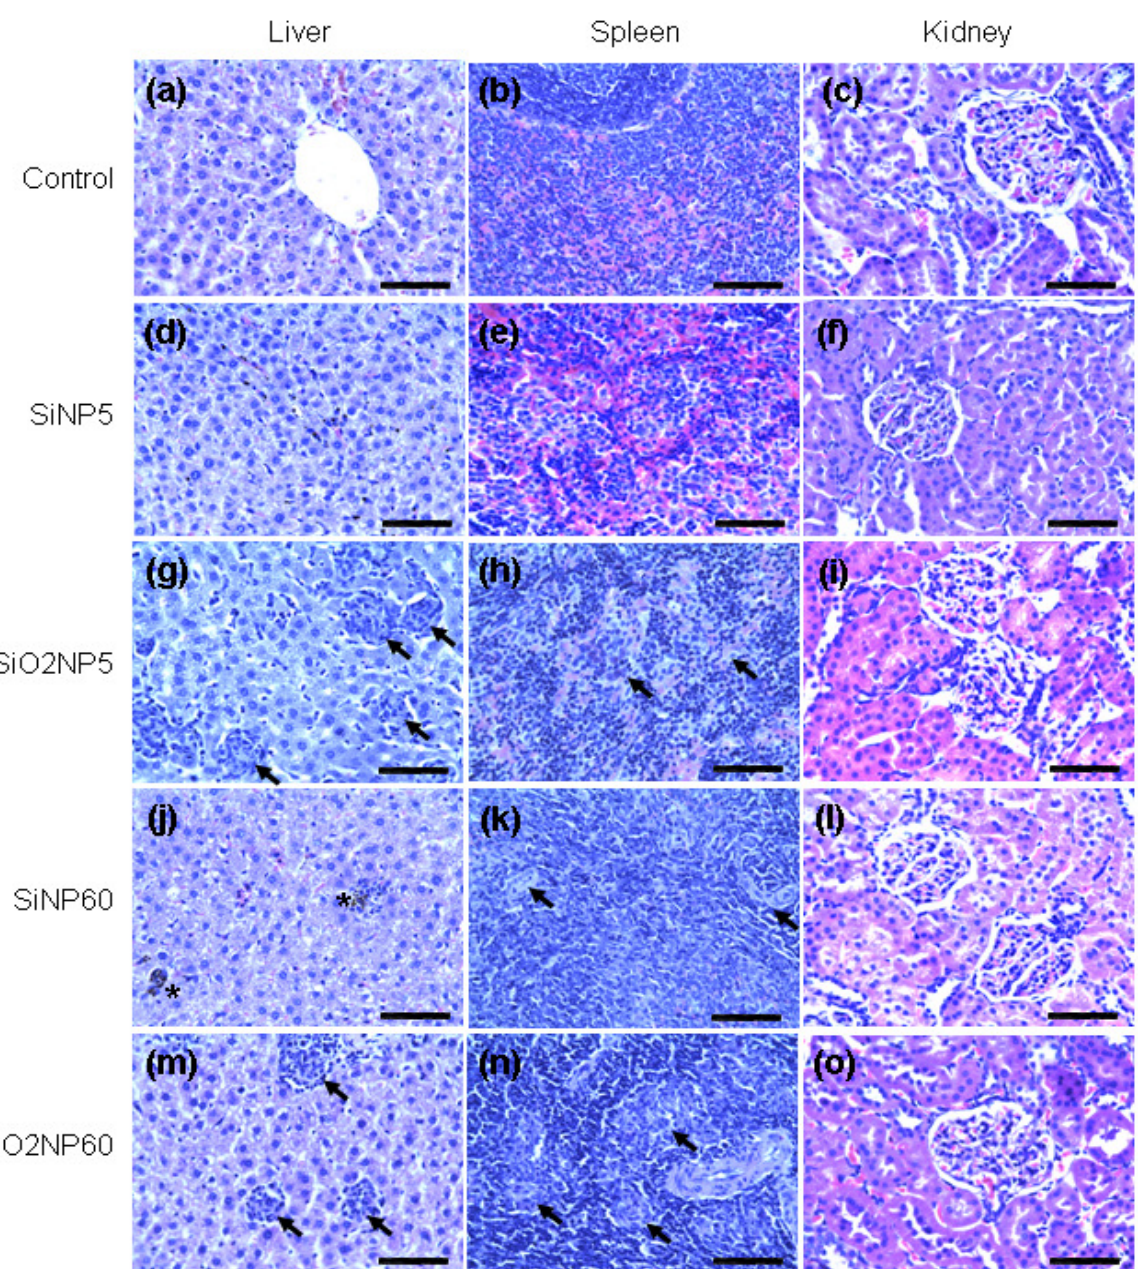
Figure 6. Histological evaluation of organs from rats treated with SiNPs or SiO NPs. Liver, 2 spleen, and kidney samples were collected at 5 and 60 days after intravenous administration of SiNPs or SiO NPs at a dose of 7 mg/kg and fixed with paraformaldehyde, 2 followed by staining with hematoxylin & eosin. ( a–c ) Vehicle-treated animals (controls); ( d–f ) 5 days after SiNP treatment (SiNP5); ( g–i ) 5 days after SiO NP treatment (SiO NP5); 2 2 ( j–l ) 60 days after SiNP treatment (SiNP60); and ( m–o ) 60 days after SiO NP treatment 2 (SiO NP60). The arrows indicate granulomas in the liver and spleen. The asterisks indicate 2 microgranulation in the liver. The tissue sections were observed under a microscope at 400×. The scale bar is 25 µ m for all images. The pictures are representative of at least 4 independent